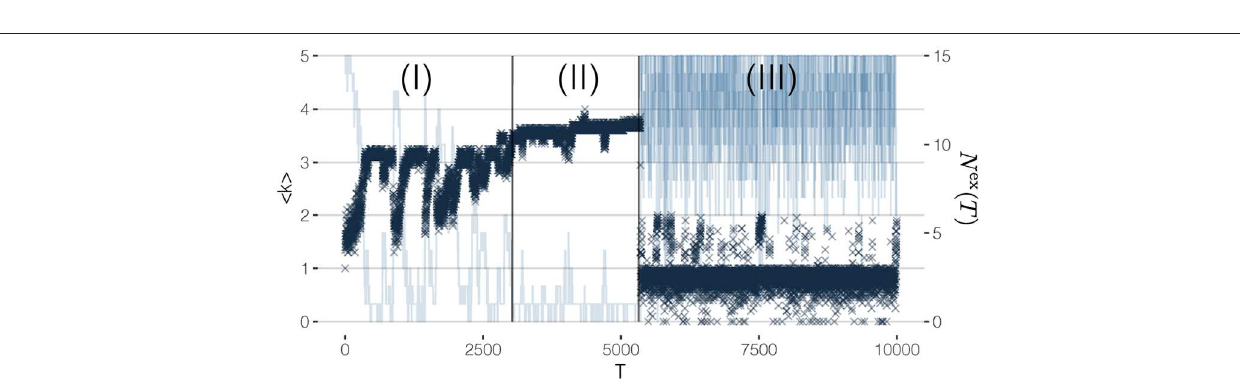
FIGURE 4 | Evolution of mean coreness and number of rewired nodes for each time step in a 20-nodes network. Three regions can be identified: (I) Build up, (II) Metastable state, (III)